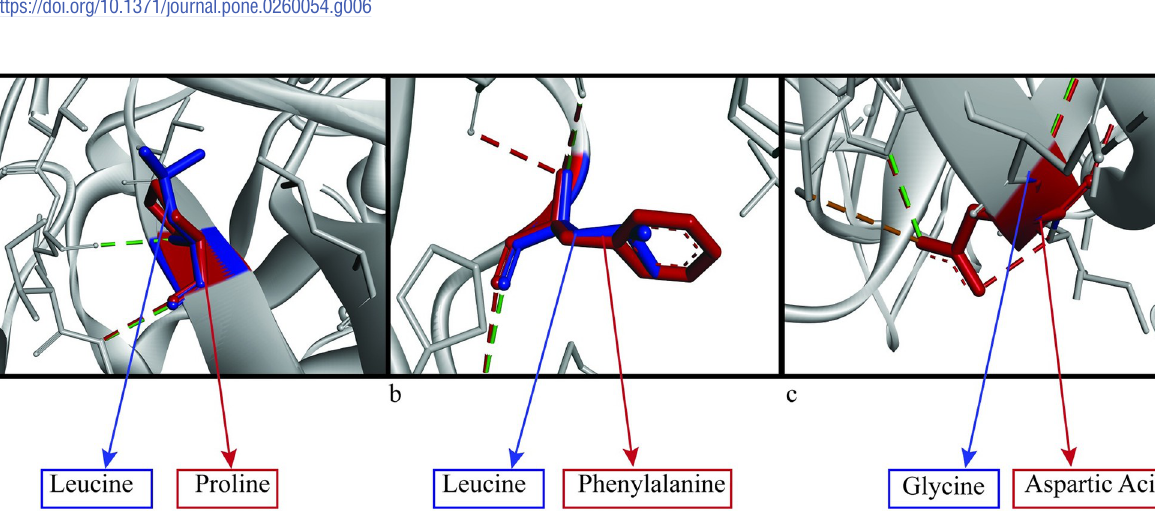
Fig 6. (a) Structural analysis showing Leu455 (blue) of native structure having 2 hydrogen bonds (green), 4 hydrophobic alkyl bonds (purple) and (b) Phe455 (green) of mutant structure having 3 hydrogen bonds (green) and 4 hydrophobic alkyl bonds